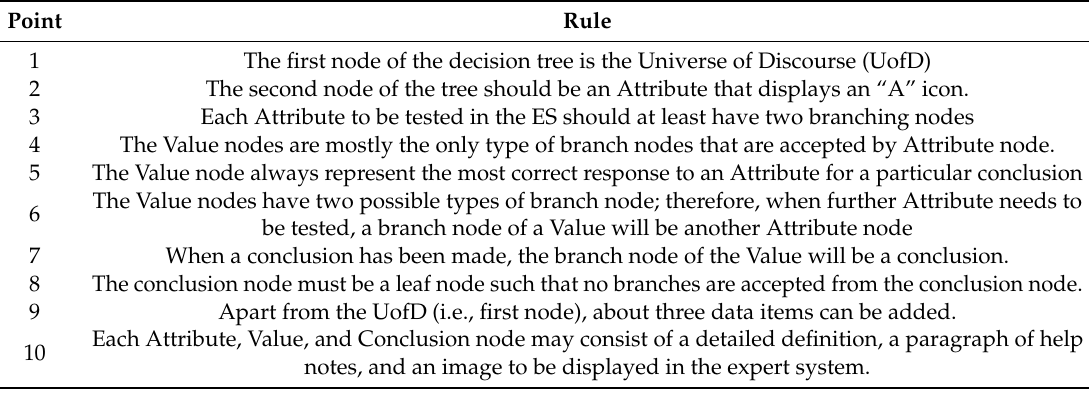
Table 3. The general rules for developing decision tree in the expert system (ES)-Builder Shell [3].